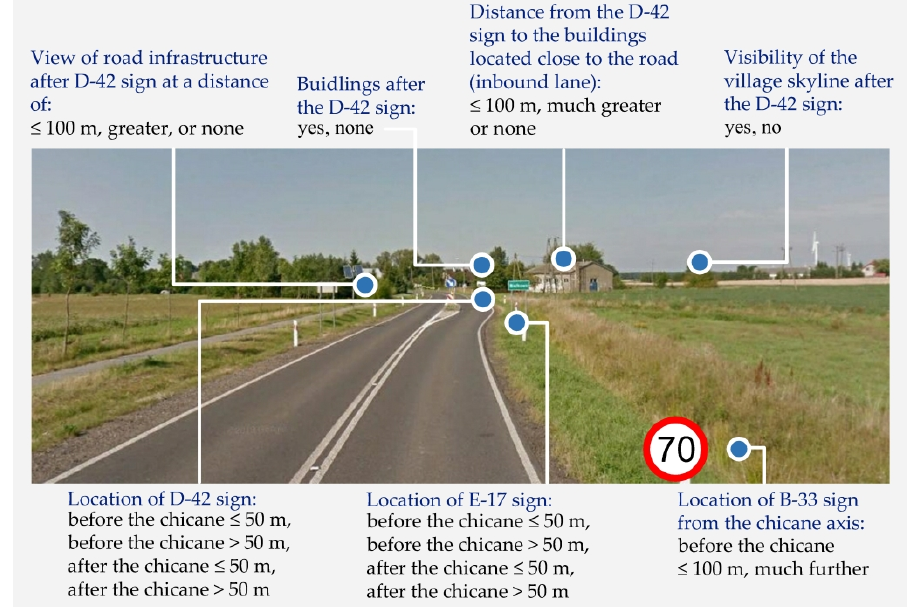
Figure 7. Factors related to the traffic management scheme chosen for the analyses (blue font designates qualitative factors and the black font–the adopted interpretation of the quantitative measure).